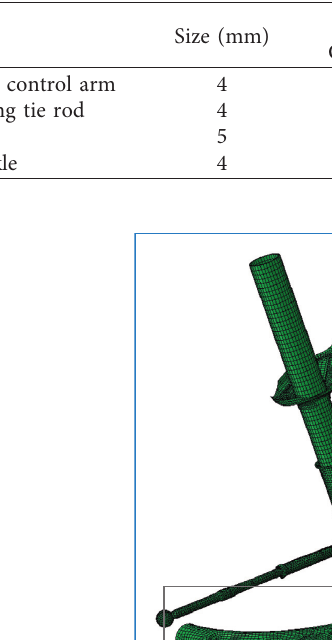
Table 3: Mesh information of suspension components.